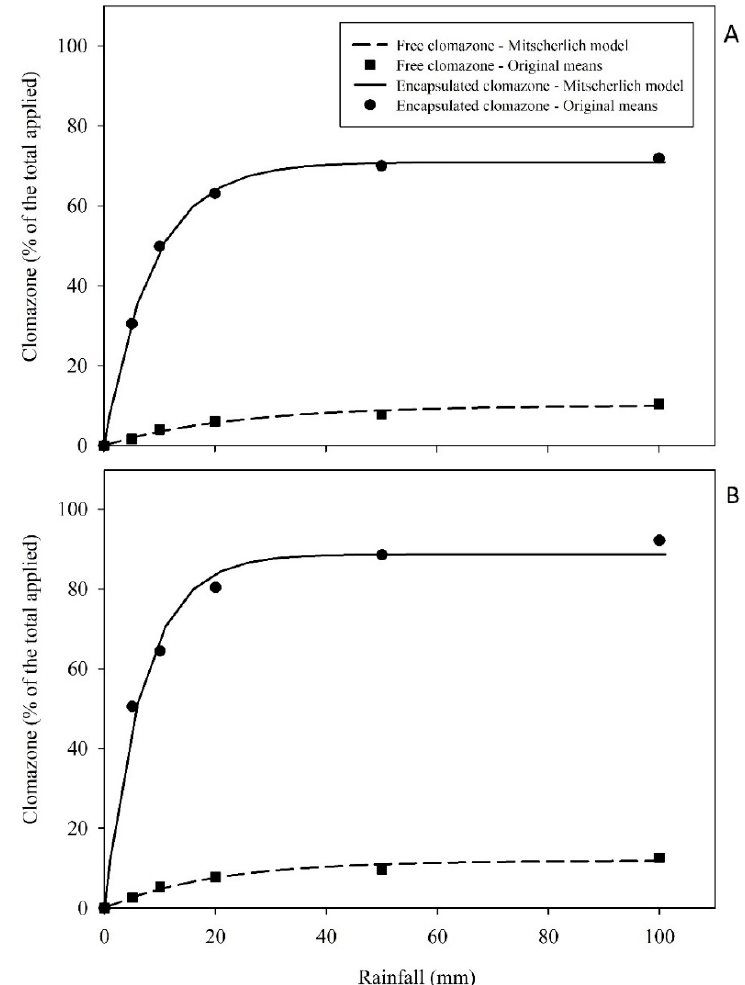
Figure 3. Quantities of free and encapsulated clomazone (% of the total applied) percolated through sugarcane straw as a function of different simulated rainfall depths (mm), after application of the microencapsulated (CS) formulation. Application only of the microencapsulated formulation ( A ); application of microencapsulated (CS) formulation combined with sulfentrazone ( B ).